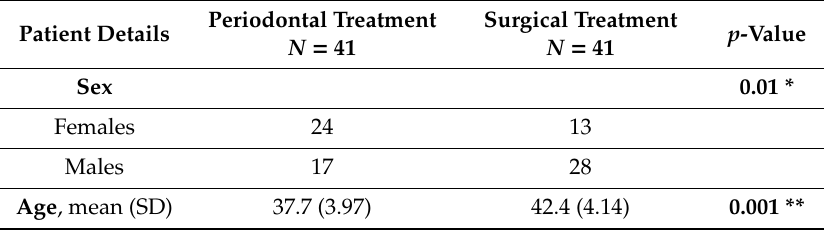
Table 1. Patients characteristics.